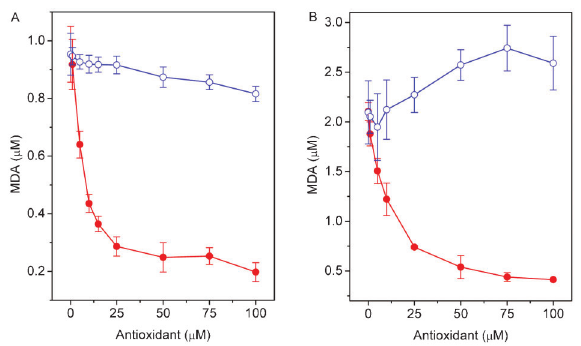
Figure 2. Effect of 4-NC (filled circles) and a -tocopherol (open circles) on MDA production in egg PC vesicles oxidized with AAPH ( A ) or FeSO 4 +H 2 O 2 ( B ). Egg PC vesicles(1.6 mM) wereincubated with several concentrations of 4-NC for 1.5 h at 37 6 C. Lipid peroxidation was initiated by a 3-h incubation with 30 mM AAPH at 37 6 C or a 1-h incubation with 0.1/1 mM FeSO 4 /H 2 O 2 at 37 6 C. 4-NC: 4-nerolidylcatechol; MDA: malondialdehyde; AAPH: 2,2 9 -azobis(2-aminopropane)hydrochloride;PC:phosphatidylcholine.